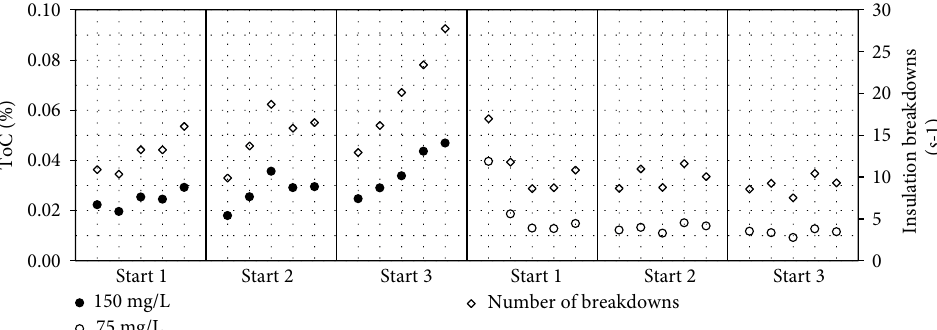
Figure 8: ToC due to carbon black particles of size 8–10 µ m at different concentration levels of 150 mg/L and 75 mg/L.